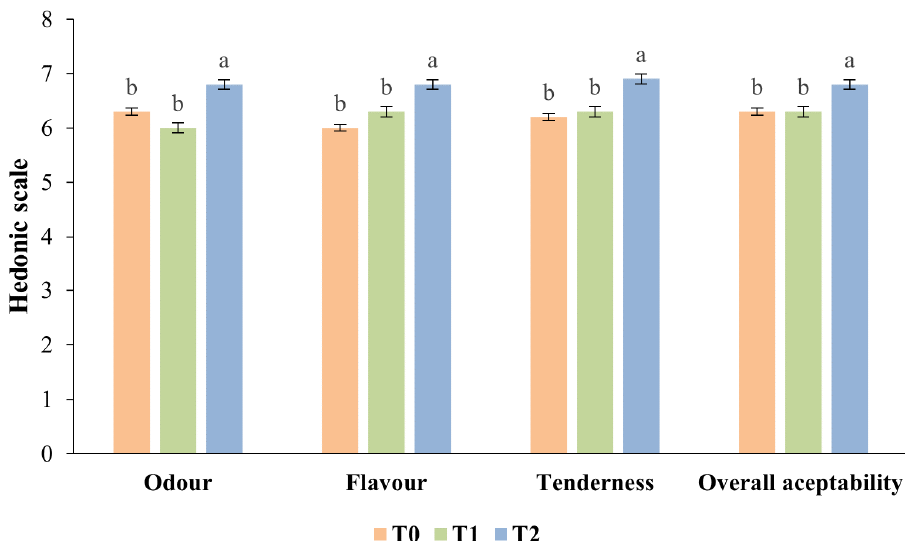
Figure 3. Sensory evaluation of frankfurters based on score acceptability (odor, tenderness, flavor and overall acceptability) of treatments T0 (frankfurter prepared without antioxidant), T1 (frankfurter prepared with Plus Color) and T2 (frankfurter prepared with murta as antioxidant). Hedonic scale from dislike extremely (1), dislike very much (2), dislike moderately (3), dislike slightly (4), like slightly (5), like moderately (6), like very much (7) and like extremely (8). Different letters indicate a significant difference between treatments ( p ≤ 0.05). Error bars correspond to standard error ( n = 130).